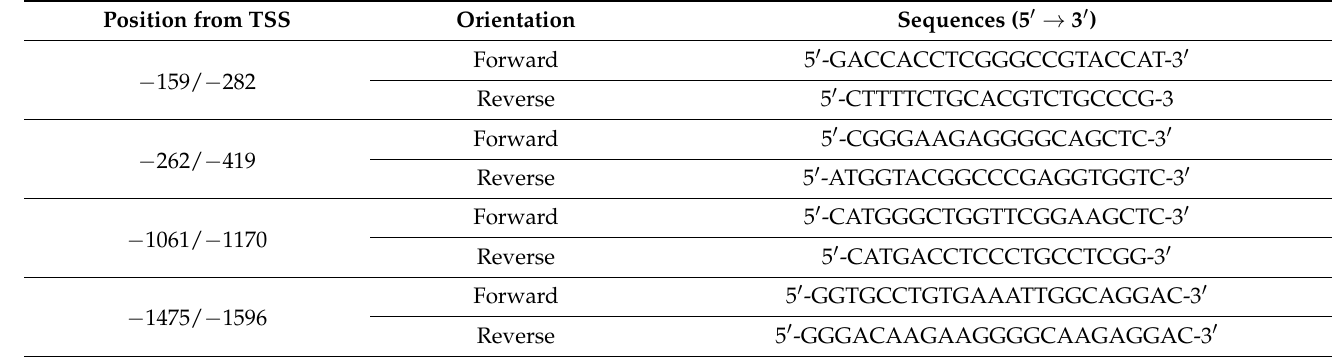
Table 2. Chromatin enrichment was normalized to input samples. Table 2. Primer sequences for ChIP